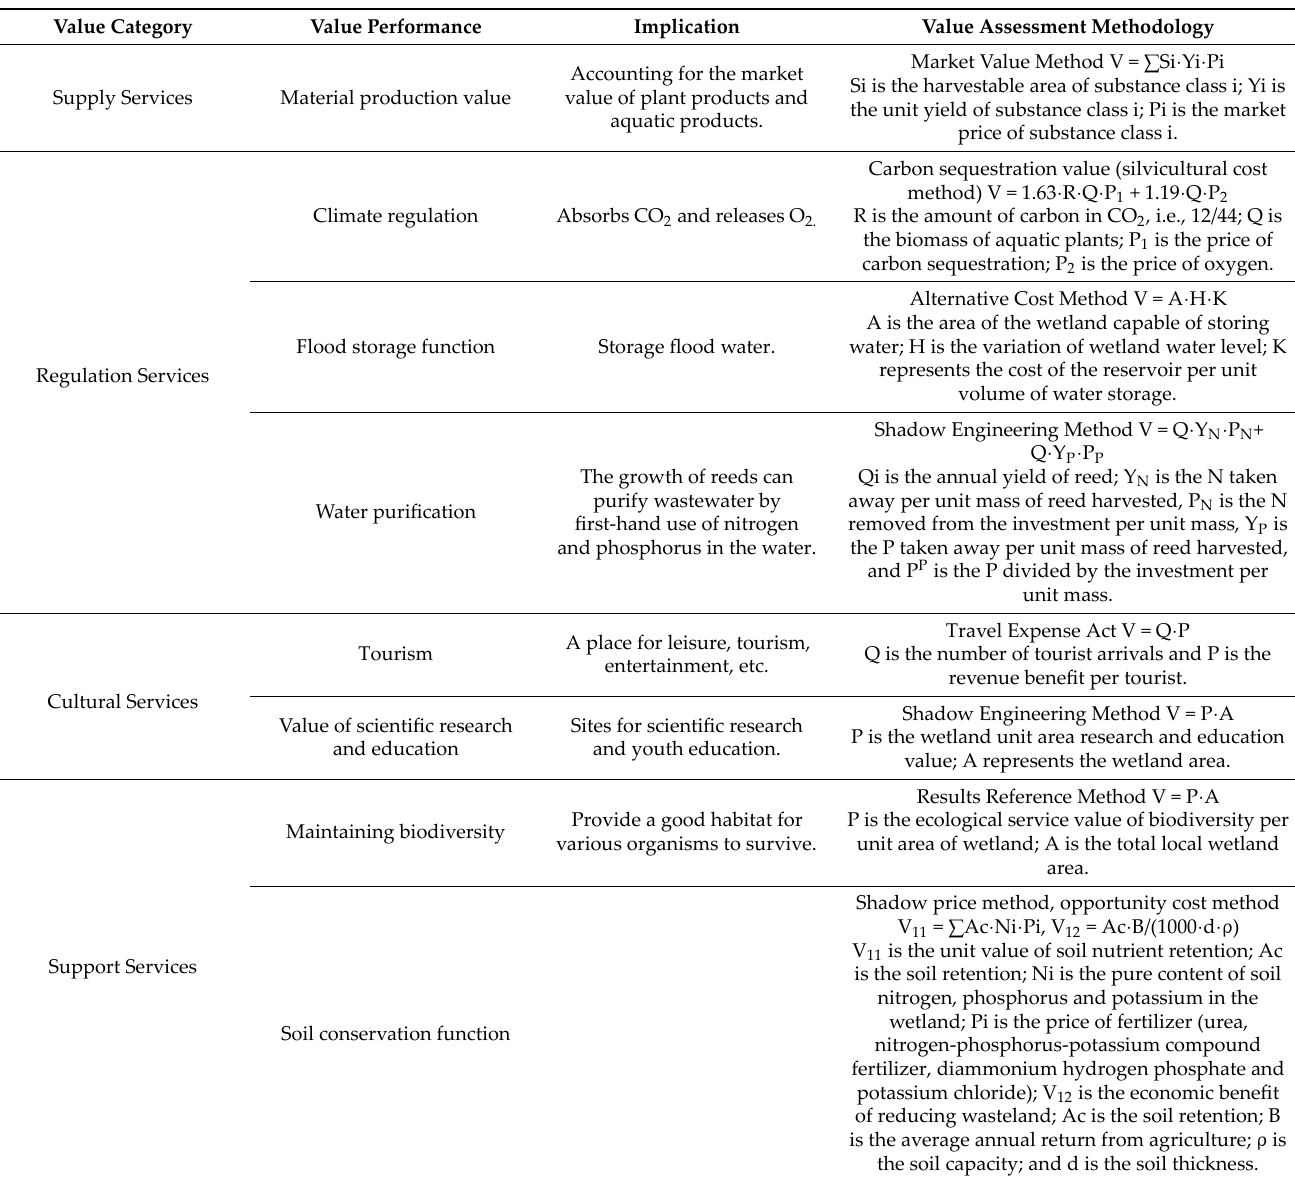
Table 3. Ecoproduct value assessment